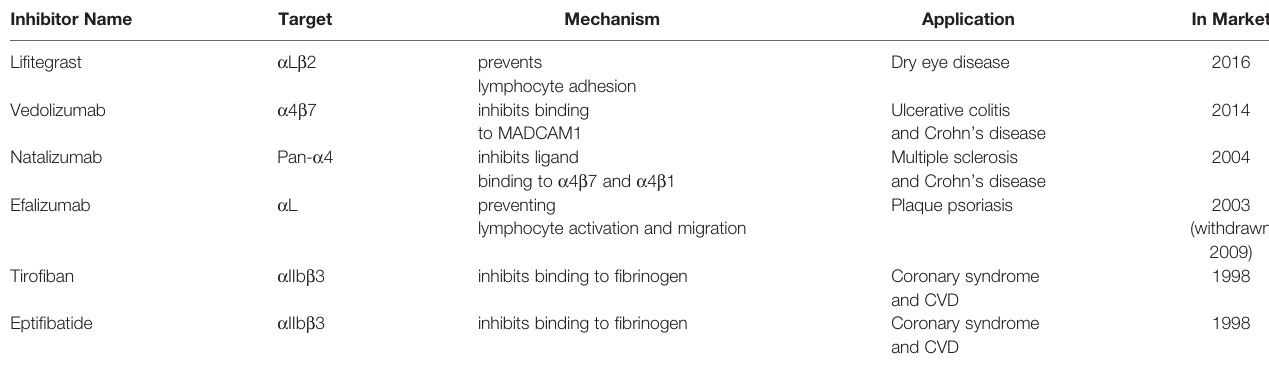
TABLE 1 | Integrin-targeting drugs once came